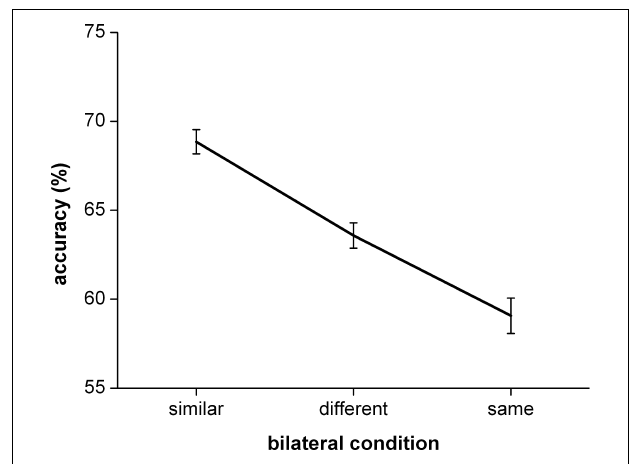
FIGURE 1 | The identifi cation performance accuracy for the low salience target stimuli over the different bilateral experimental conditions. Error bars refl ect normalized standard error of the